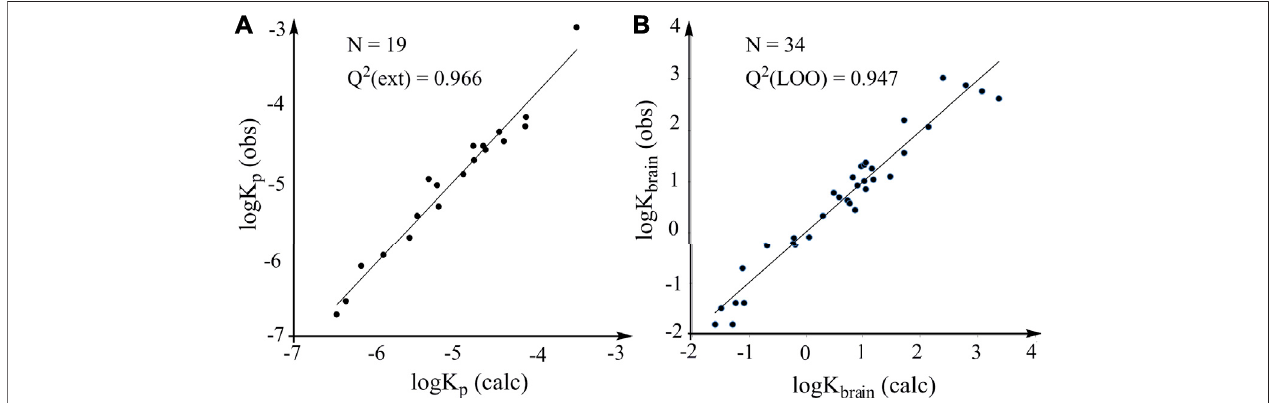
FIGURE4| PredictivepowerofmodelsconstructedaccordingtotheLFER. (A) Externalvalidation.PlotsofobservedlogK p (logofhumanskinpermeability)against the logK p calculated from the model constructed according to the LFER (logP oct is used). (B) LOO cross-validation. Plots of observed logK brain against the logK brain calculated from the model constructed according to the